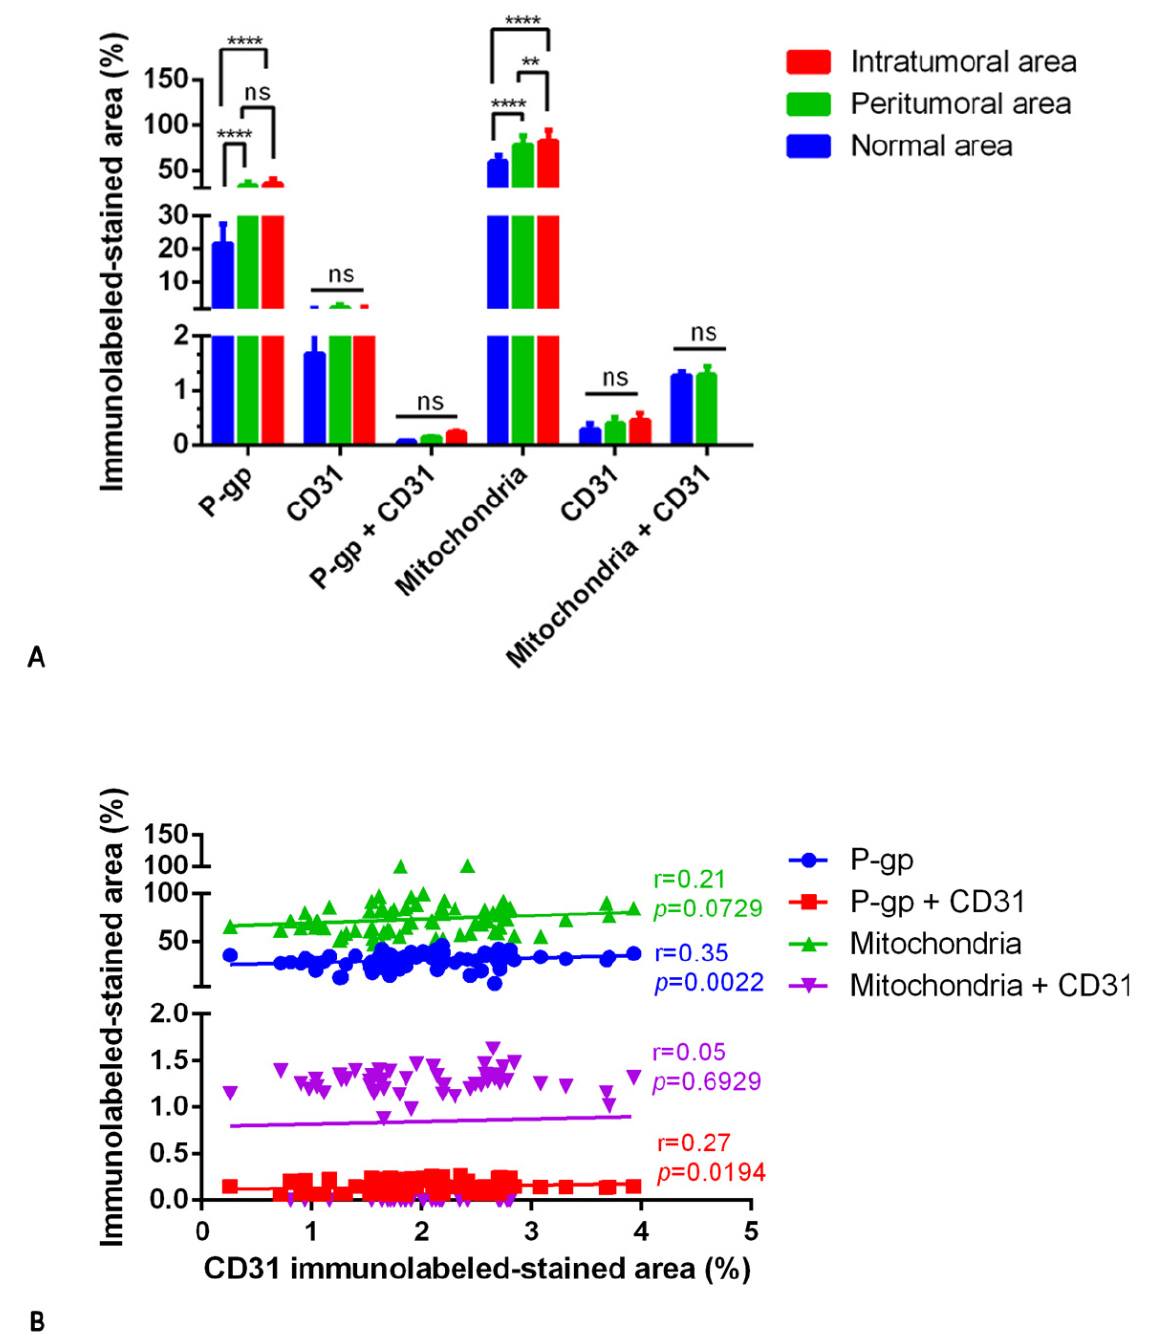
Figure 7. P-gp/CD31 and mitochondria/CD31 quantification in IDH-mutant astrocytoma. P-gp, mitochondria, and CD31 were evaluated by immunohistochemistry and were estimated as a percentage of digital quantification within the same spatial ROIs on IDH-mutant astrocytoma serial sections using the colocalization algorithm. P-gp and mitochondria are significantly overexpressed in peritumoral and intratumoral areas versus the normal one ( A ). No significant differences are noted in CD31, P-gp + CD31, or mitochondria + CD31 expression in all three areas ( A ). Linear regression analysis ( B ) shows a poor or fair statistical correlation between the CD31 expression and the other immunolabeled markers [For P-gp: Y = 2.824*X + 24.30; for P-gp + CD31: Y = 0.01772*X + 0.1134; for mitochondria: Y = 4.024*X + 64.79; for mitochondria + CD31: Y = 0.02627*X + 0.7950]. Data are reported as mean ± SD, and the Tukey’s post hoc test was used to compare all groups after two-way ANOVA. N = 25. ns, not significative; ** p < 0.01; **** p < 0.0001.